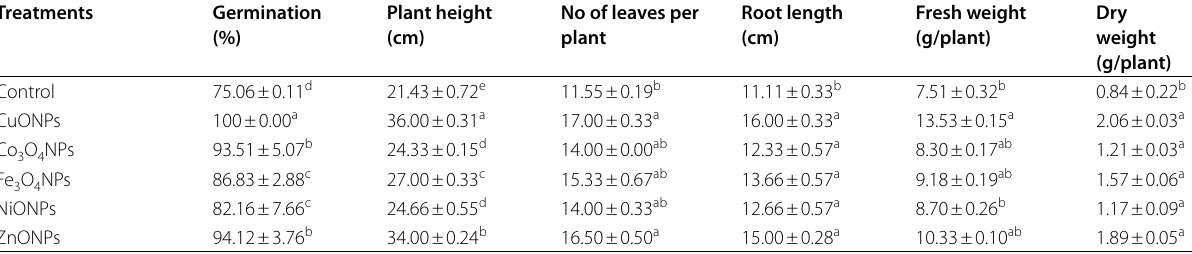
Table 5 Impact of NPs on the germination and vegetative growth parameters of P. vulgaris Treatments